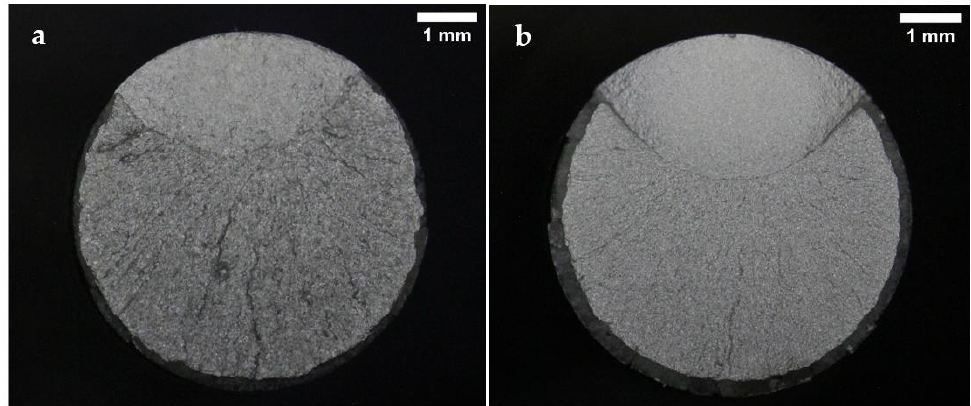
Figure 8. Fracture surfaces after fatigue tests of ( a ) A-type and ( b ) B-type H13 steels, tested in air to a maximum stress of 1070 MPa (75% and 72% YS, respectively).